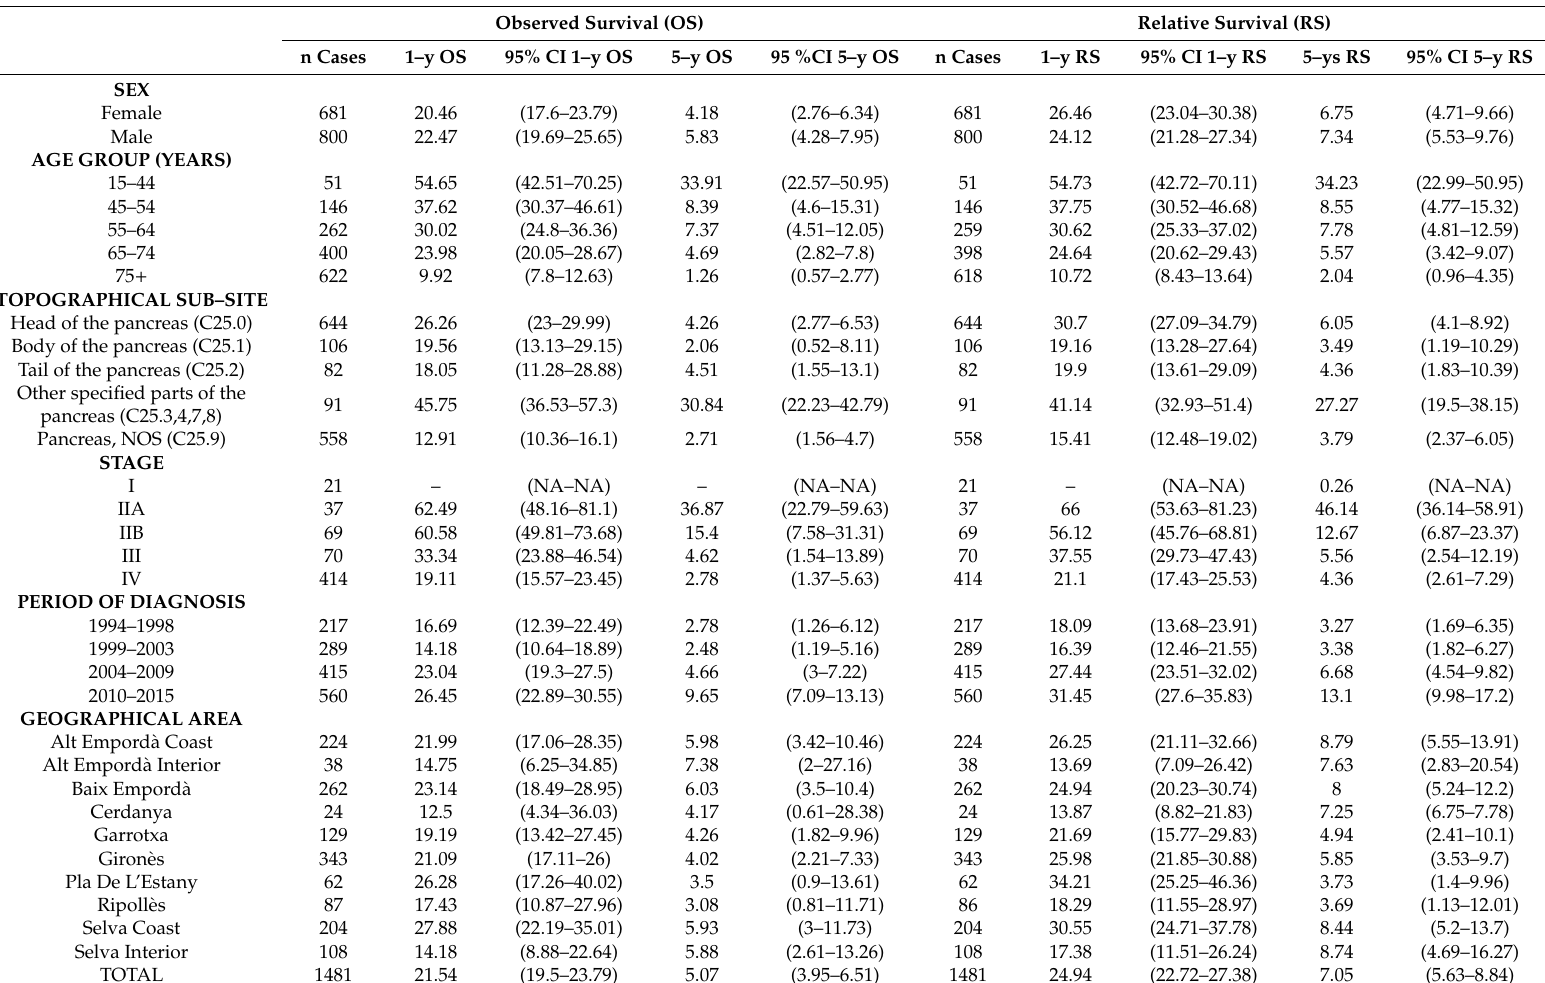
Table 3. One and 5-year observed and relative survival for all pancreatic cancers by sex, age, stage, period of diagnosis, sub-site and county. Girona province,